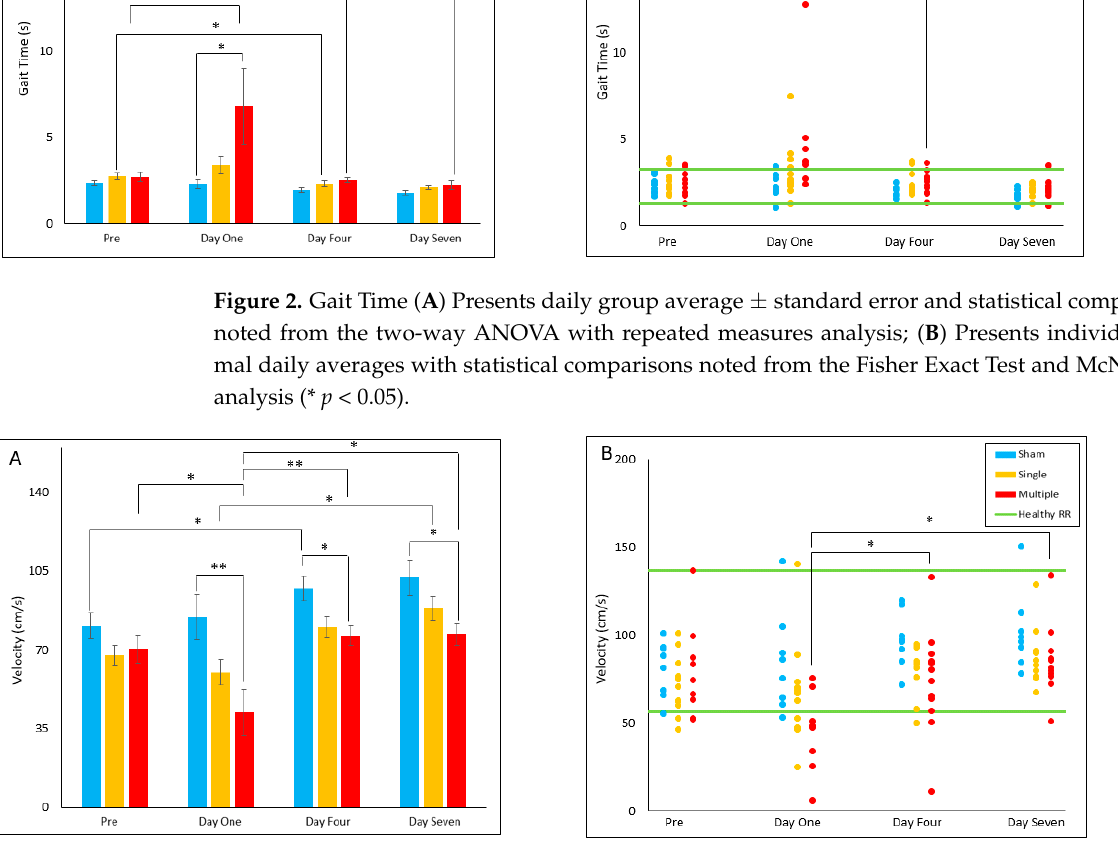
Figure 3. Gait Velocity ( A ) Presents daily group average ± standard error and statistical comparisons noted from the two-way ANOVA with repeated measures analysis; ( B ) Presents individual animal daily averages with statistical comparisons noted from the Fisher Exact Test and McNemar’s analysis (* p < 0.05, ** p <